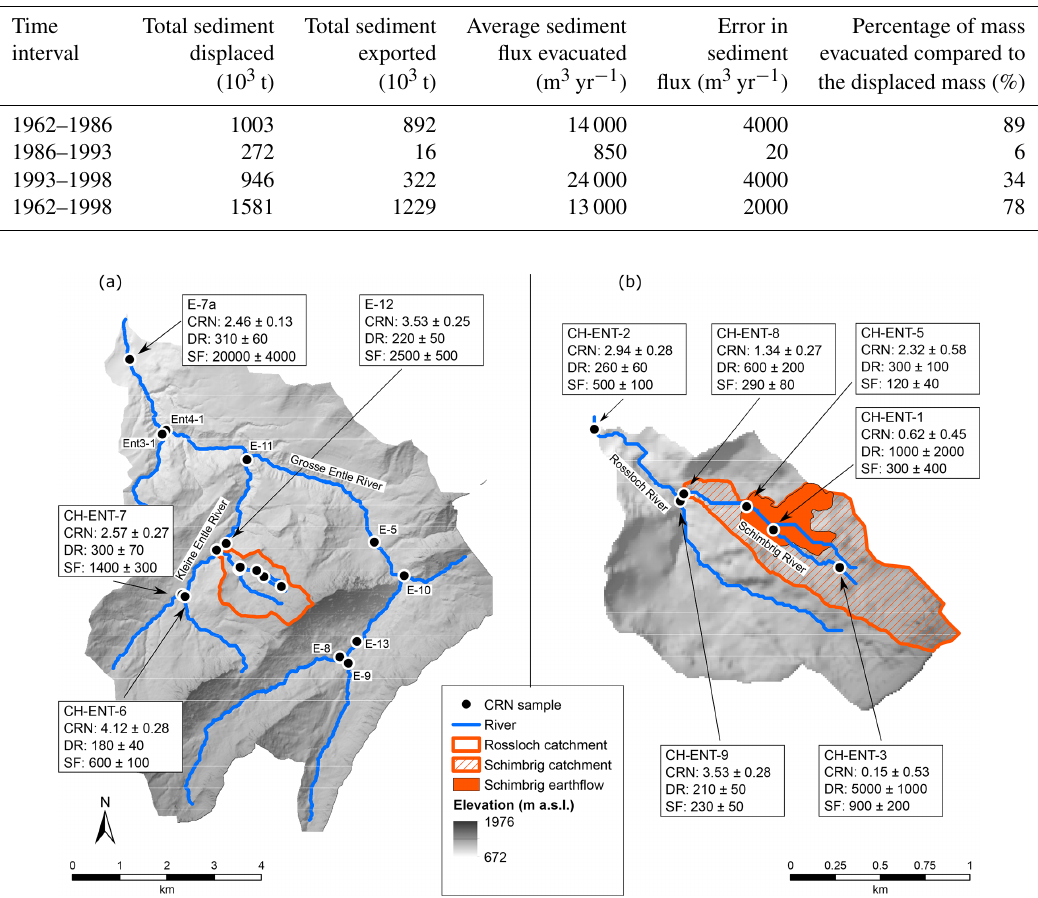
Figure 4. Location of CRN samples in the Entle catchment. CRN concentrations (CRN; × 10 3 atoms g − 1 ), denudation rates (DR; mmkyr − 1 ) and sediment fluxes (SF; m 3 yr − 1 ) displayed are discussed in the text. Values are available in Table 3. (a) Entle River and (b) Rossloch River catchments. The Schimbrig catchment is depicted by the hatched polygon within the Rossloch catchment in panel (b) . Source of the DEM: Swiss Federal Office of Topography Swisstopo